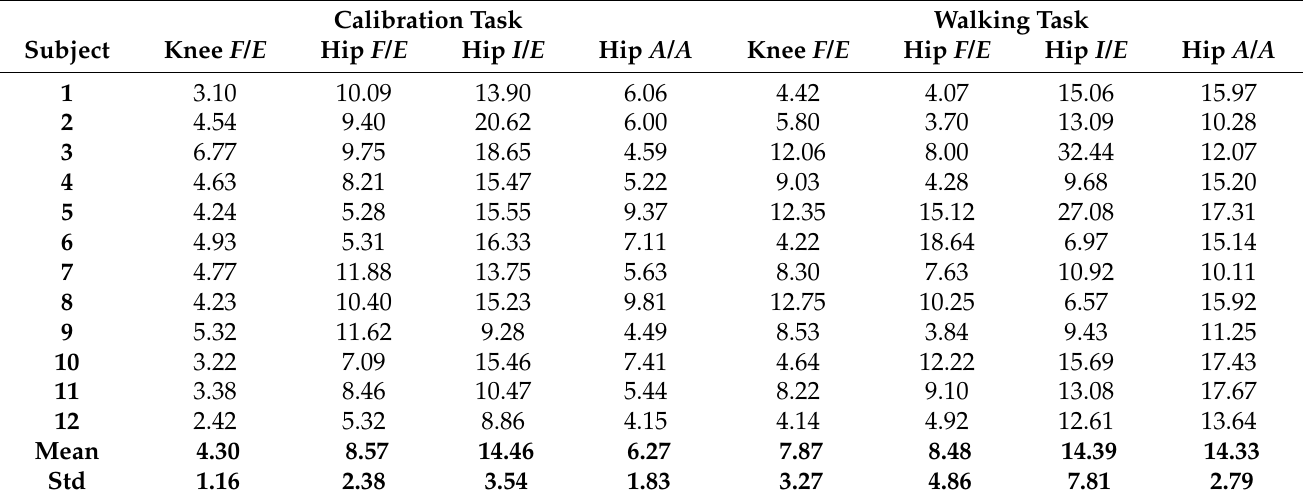
Table 1. RMSE (degrees) of absolute IMU joint angles vs. mocap joint angles for both the calibration and walking tasks. F/E , I/E , and A/A refers to flexion/extension, internal/external rotation, and abduction/adduction of the joint, respectively. Values are the average value for the right and left leg.